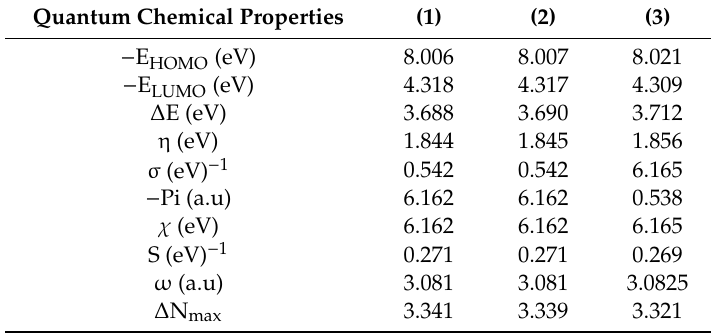
Table 7. The measured quantum chemical propertiesfor spiropyrazoles products. Quantum Chemical Properties